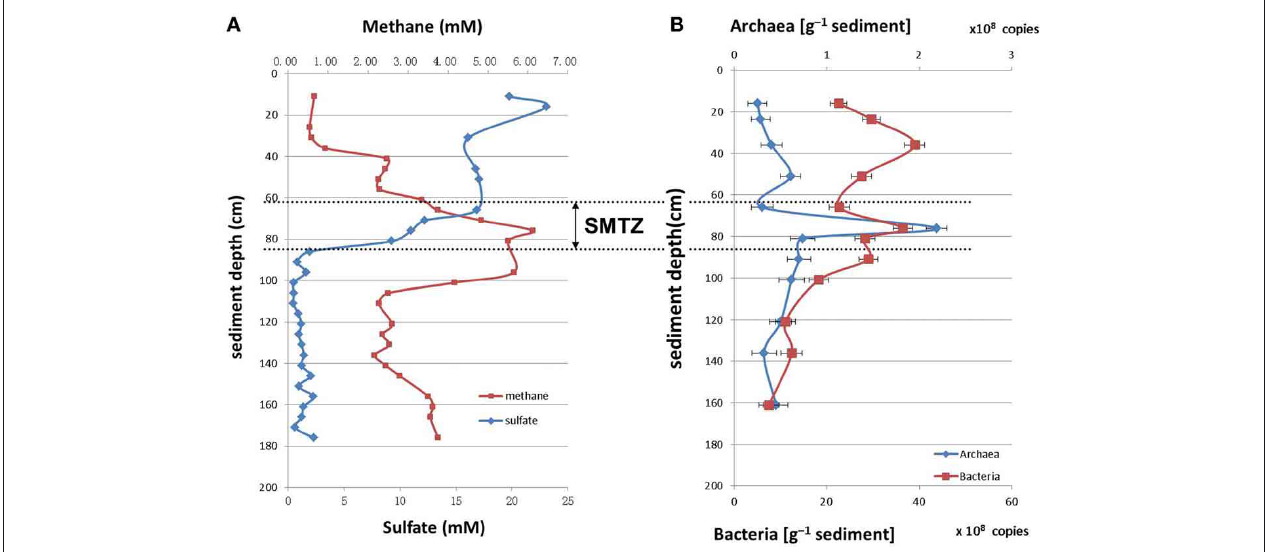
FIGURE 1 | Depth distributions of methane/sulfate concentrations (A) and archaeal/bacterial16S rRNA gene abundances (number of gene copies/g [wet weight]) (B) in sediments of Jiulong River estuary.